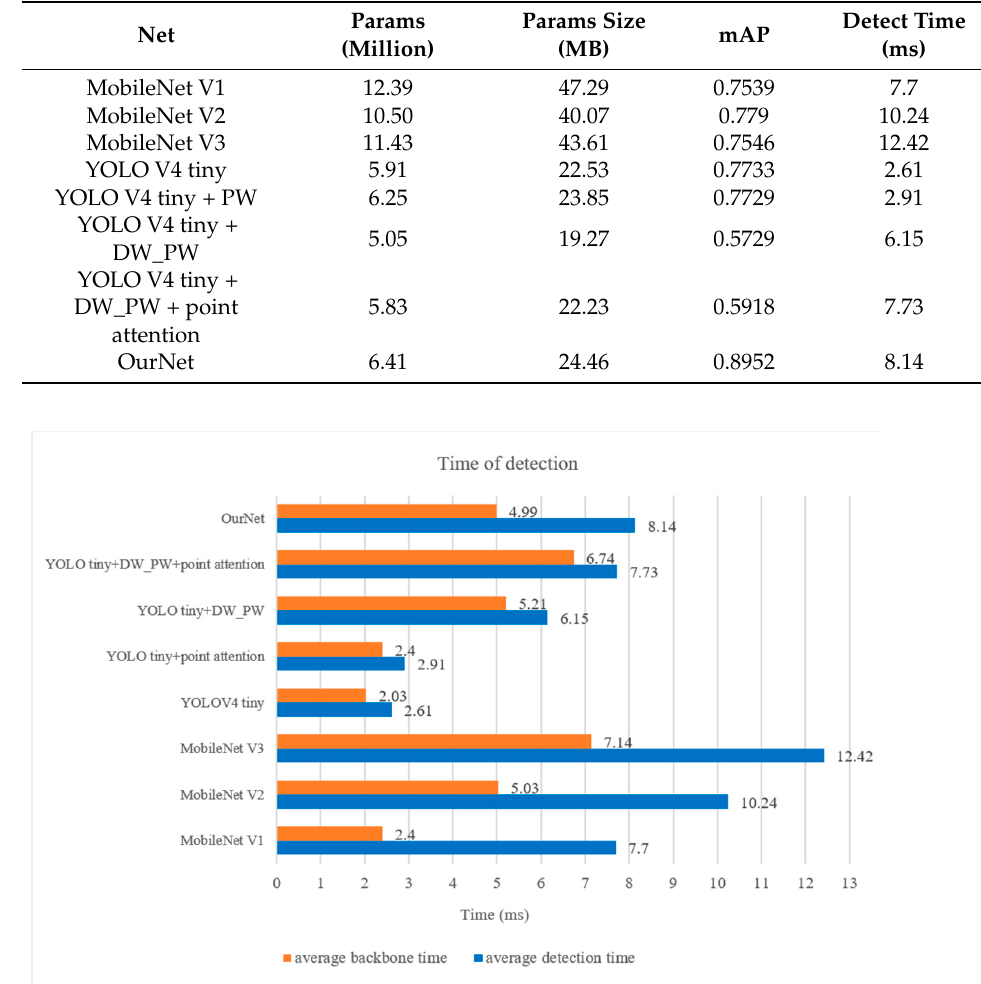
Figure 10. Response time of backbone network and detection network of different models.